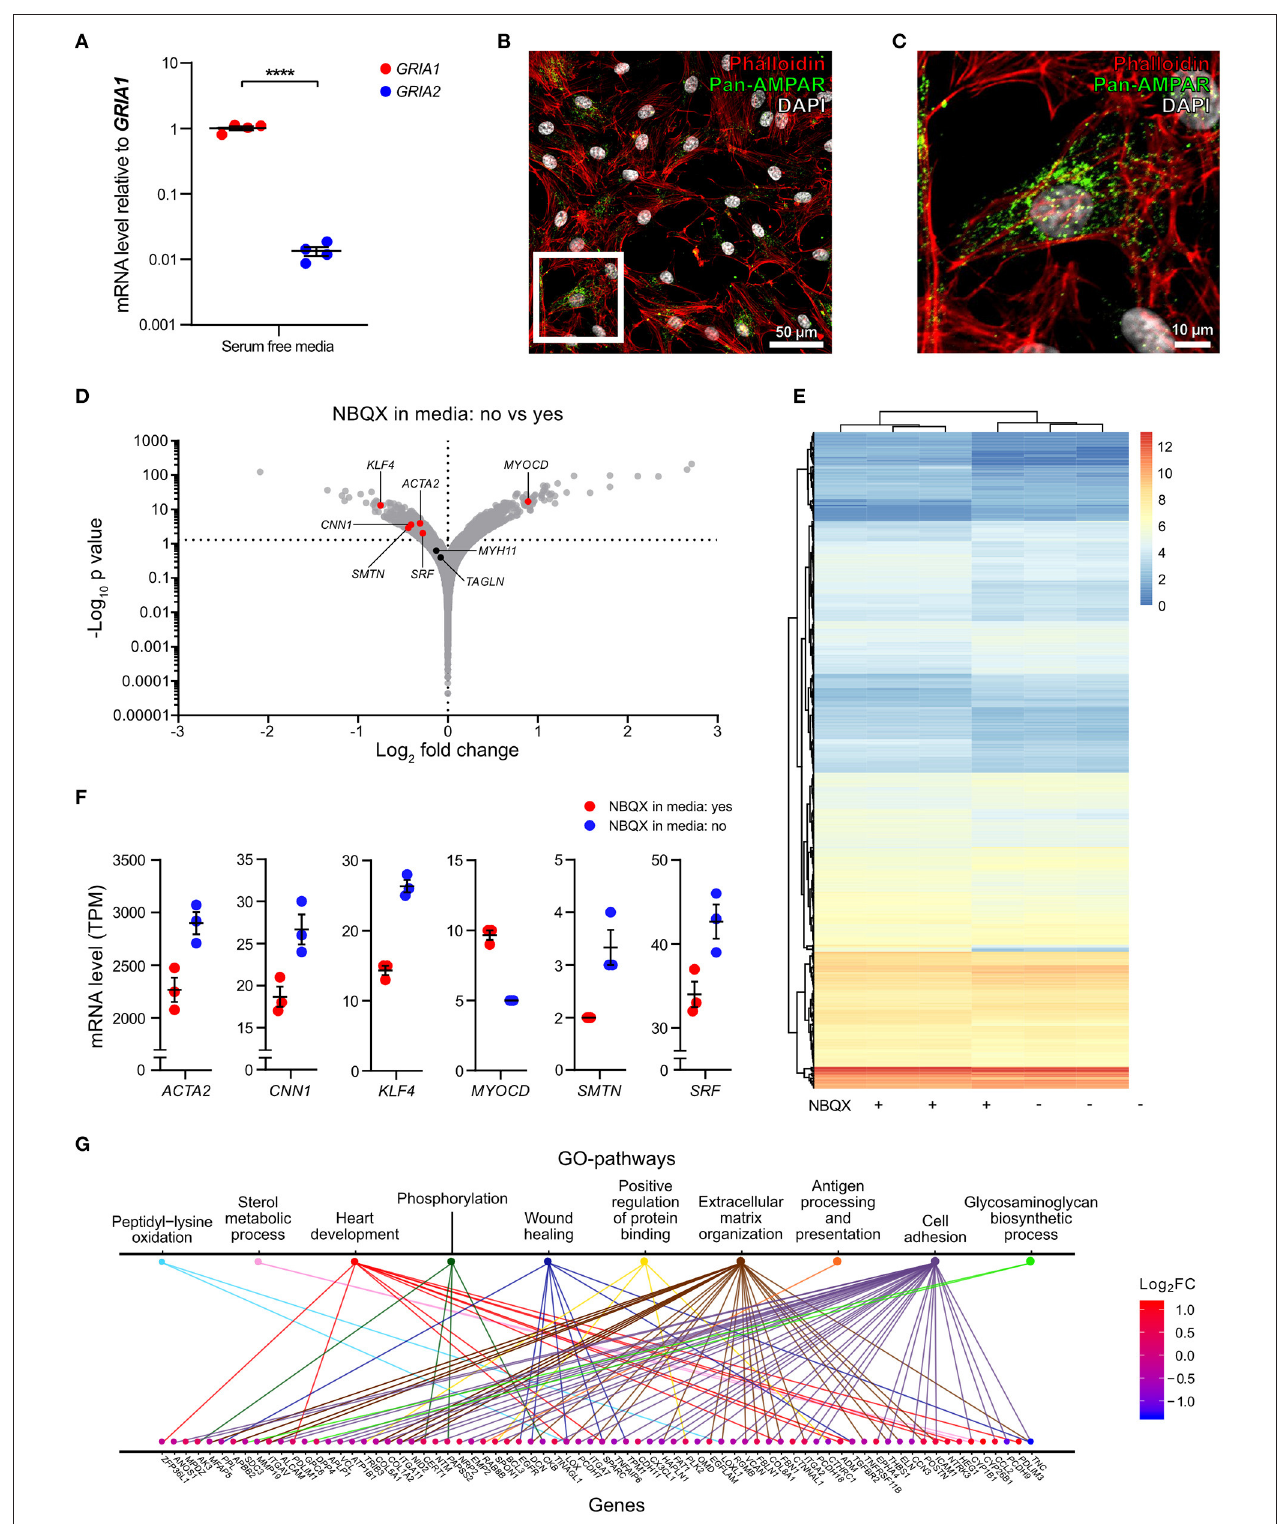
FIGURE 4 | AMPA receptors regulate a gene set associated with VSMC phenotypic modulation in vitro . (A) Dot plot indicating the relative expression of GRIA1 , and GRIA2 in human carotid smooth muscle cells (hcSMCs) maintained for 24h in serum free media ( n = 4). mRNA levels were quantified using qPCR and are